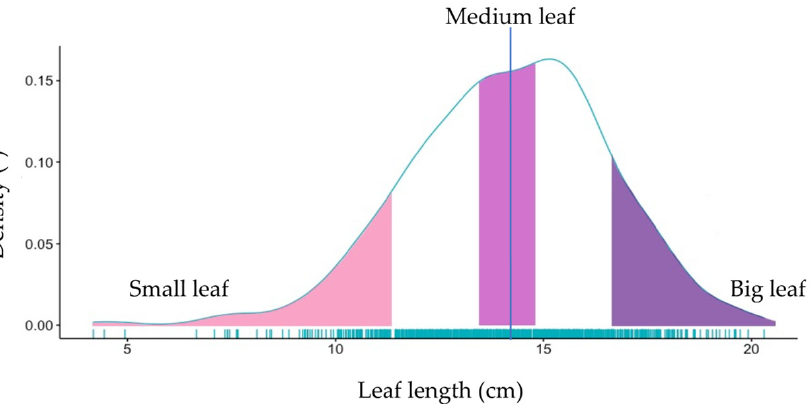
Figure 3. The distribution of leaf length of the plant samples (averaged for each plant) measured on 22 September. Three plant groups (small, medium, big; n = 20) of digitized plant 3D models were randomly selected for reconstruction of virtual canopies based on leaf length. The vertical line indicates the average leaf length (=14.1 cm).